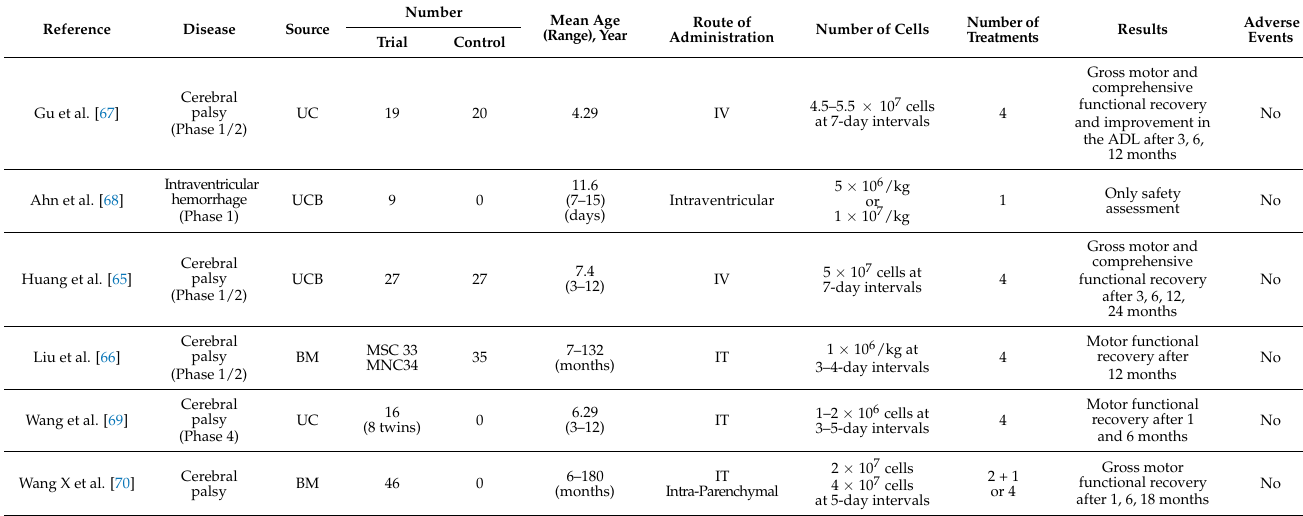
Table 3. Summary of recent clinical trials using MSCs for cerebral